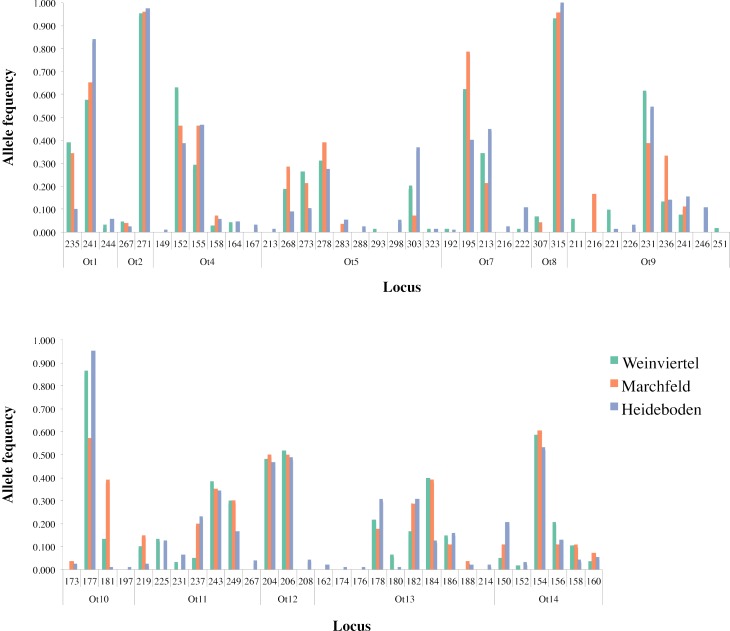
Allele frequency distribution of the twelve analysed microsatellite loci across the three breeding areas.